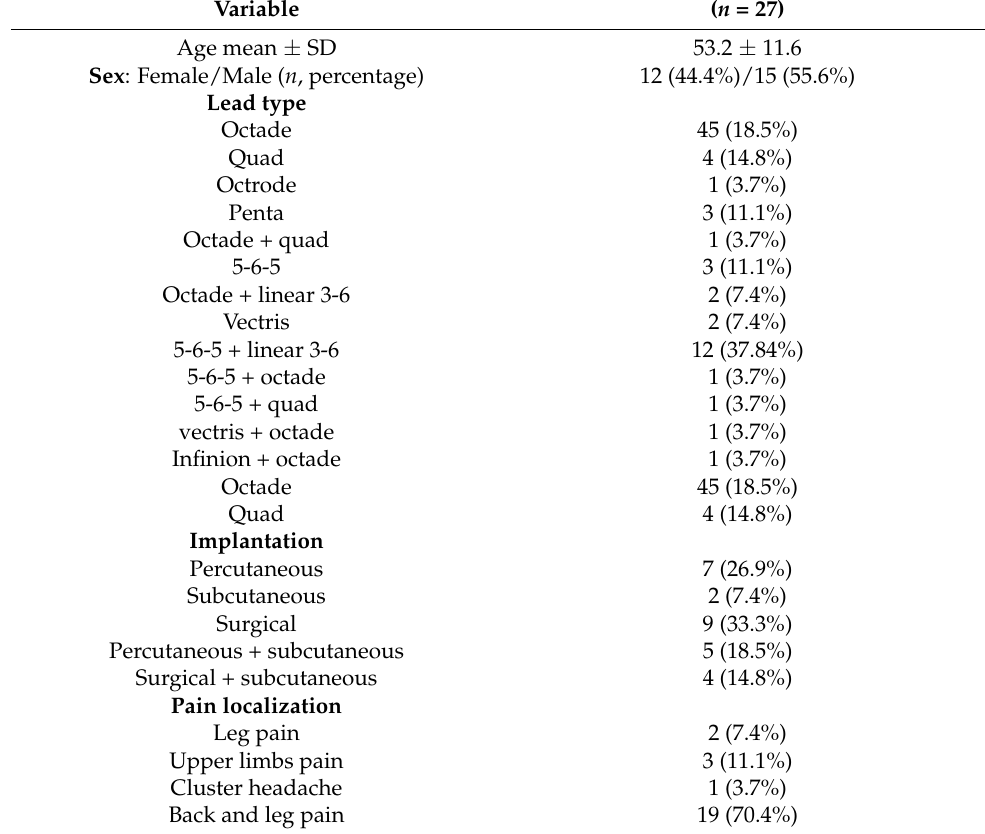
Table 1. Patients baseline sociodemographic and clinical